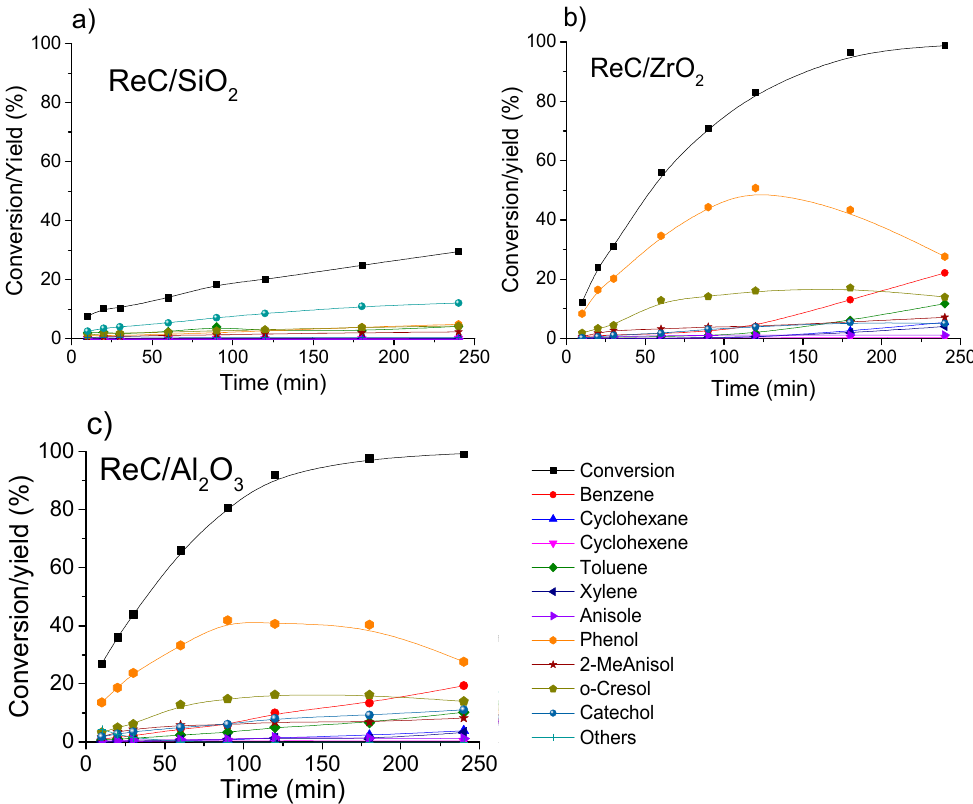
Figure 9. Evolution of guaiacol conversion and the products yield for the different catalyst ( a ) ReC/SiO 2 ( b ) ReC/ZrO 2 and ( c ) ReC/Al 2 O 3 . Reaction conditions: 200 mg catalyst, 350 °C, 5.0 MPa H 2 .